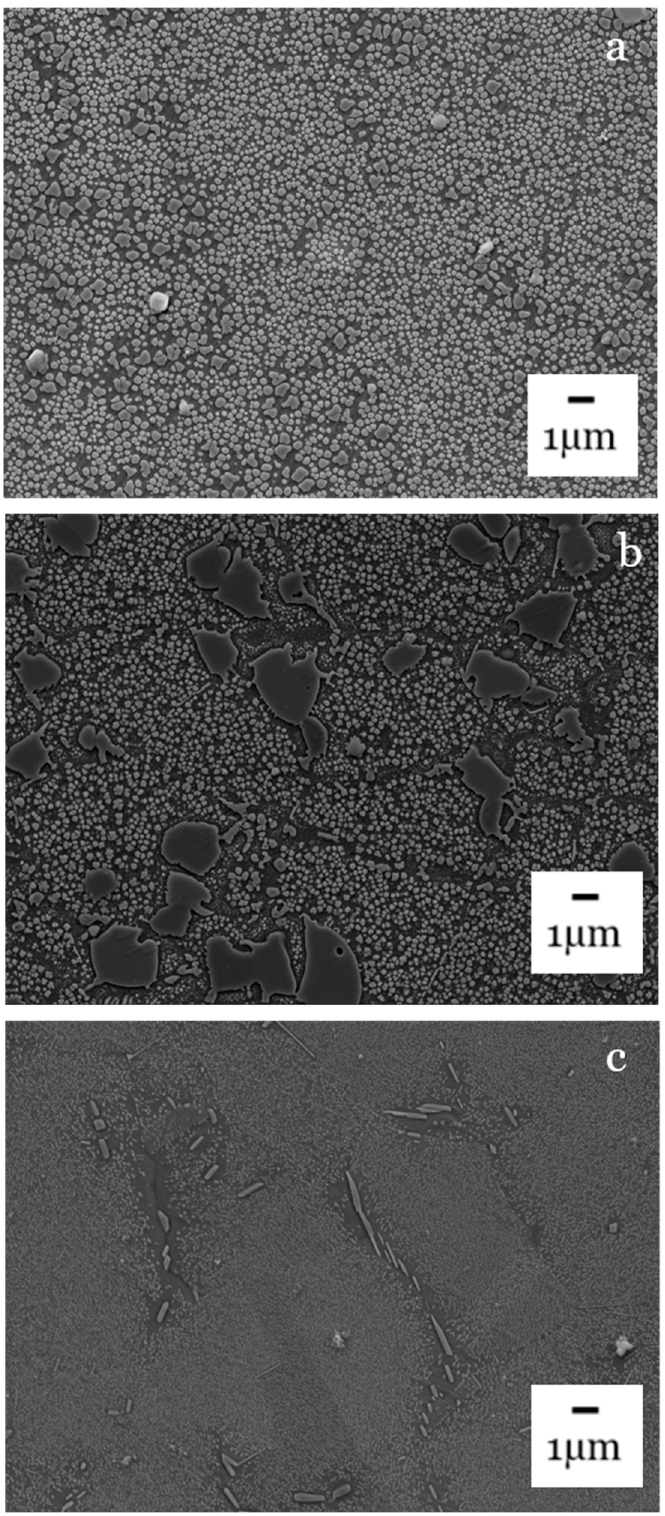
Figure 7. FEG-SEM of base materials: ( a ) new generation nickel-based superalloy, ( b ) RR1000, ( c ) Inconel 718 .